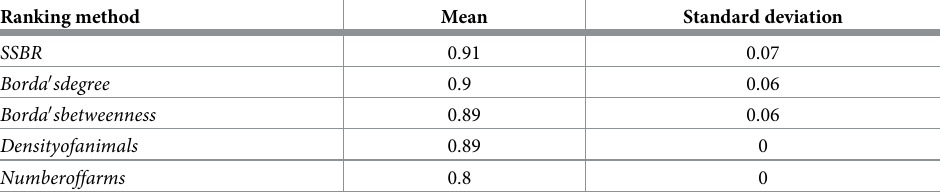
Table 1. The area under the ROC for five different methods for ranking regions likely affected by FMD. The pro- posed method SSBR combines different degree and betweenness features. The Borda degree and betweenness combine degree and betweenness features, respectively. Two rankings rely on the density of animals and the number of farms.